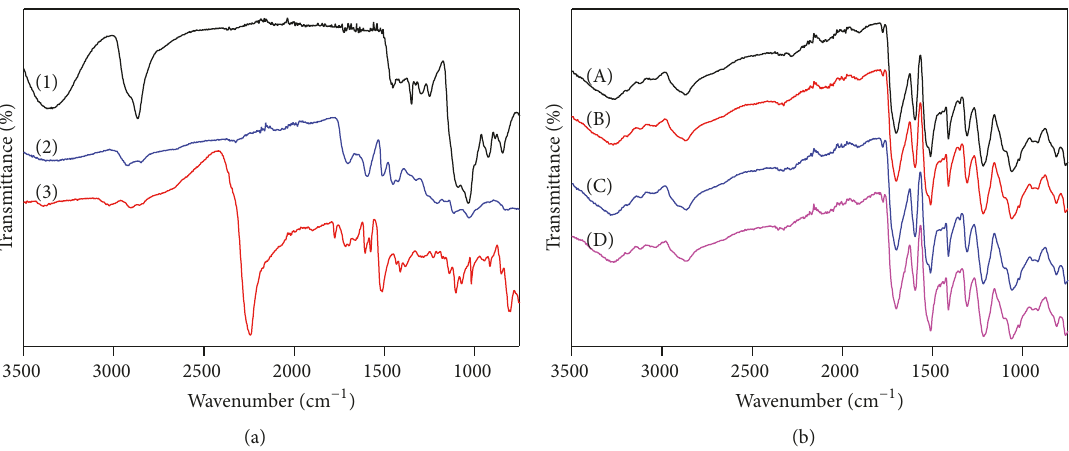
Figure 2: FTIR spectra of (1) polyol, (2) Switchgrass lignin, and (3) MDI; (A) pure polyol, (B) 5% lignin, (C) 10% lignin, and (D) 15% lignin content polyurethane